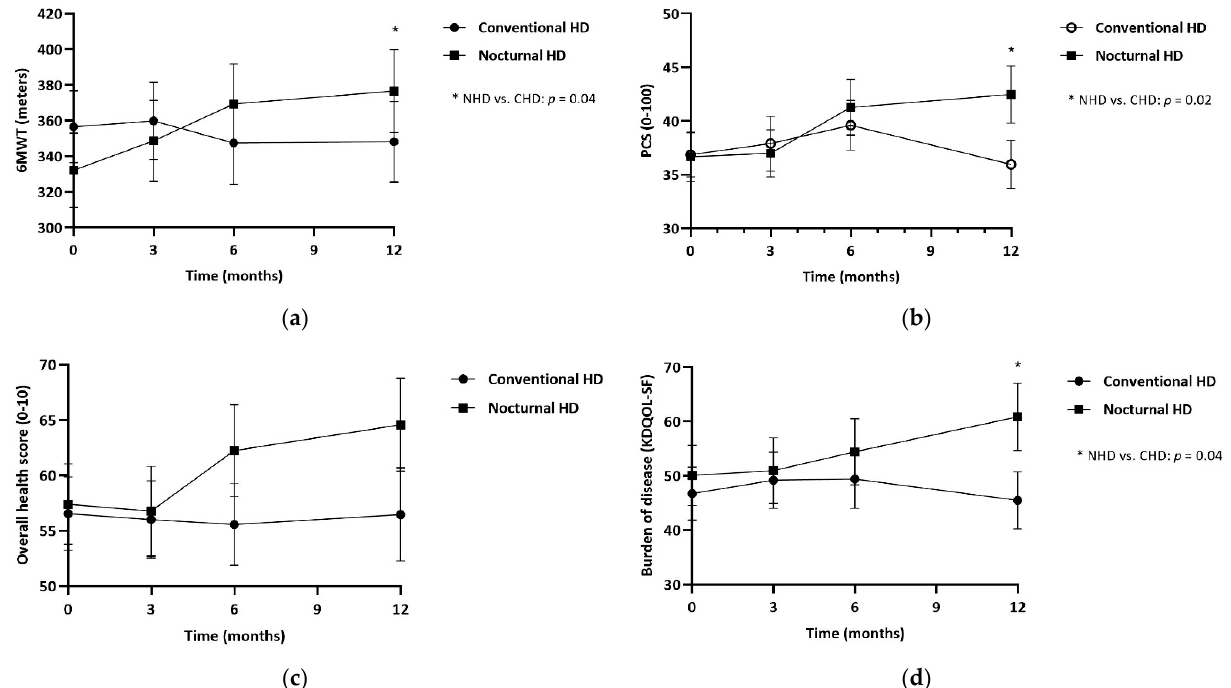
Figure 2. Estimated marginal means at 3, 6 and 12 months, for patients treated with NHD and CHD. ( a ) 6-minute walk test in meters; ( b ) Physical component summary score (PSC score, 0–100) by KDQOL-SF; ( c ) Overall health score (0–10) by KDQOL-SF; ( d ) Burden of kidney disease by KDQOL-SF. * p ≤ 0.05.